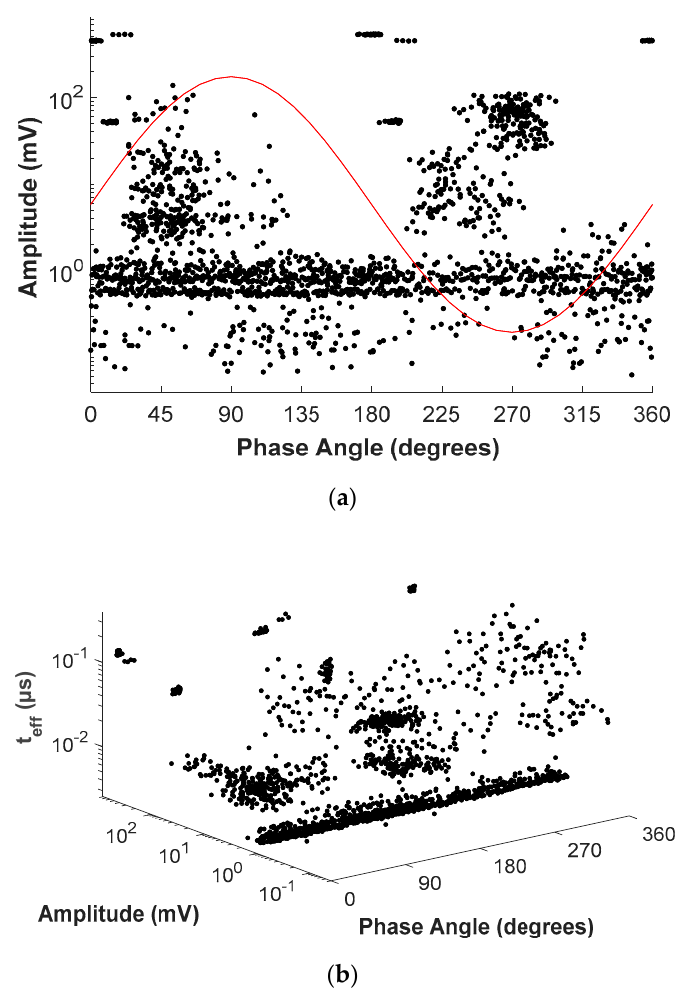
Figure 10. Measured PRPD patterns: ( a ), classical and ( b ), proposed PRPD- t eff pattern for case study .